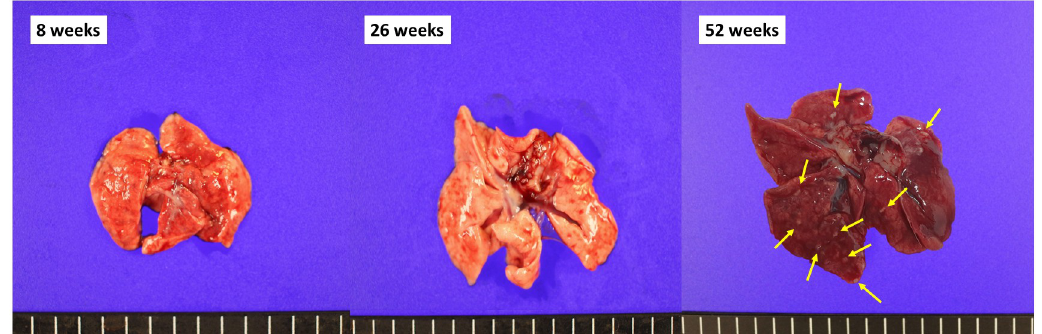
Fig 6. Gross pictures of extracted lungs at 8, 26, and 52 weeks-post PHMG exposure. Multiple yellowish nodules were disseminated on the surface of both lungs 52 weeks-post PHMG exposure (arrows). These disseminated nodules were bronchiolo-alveolar